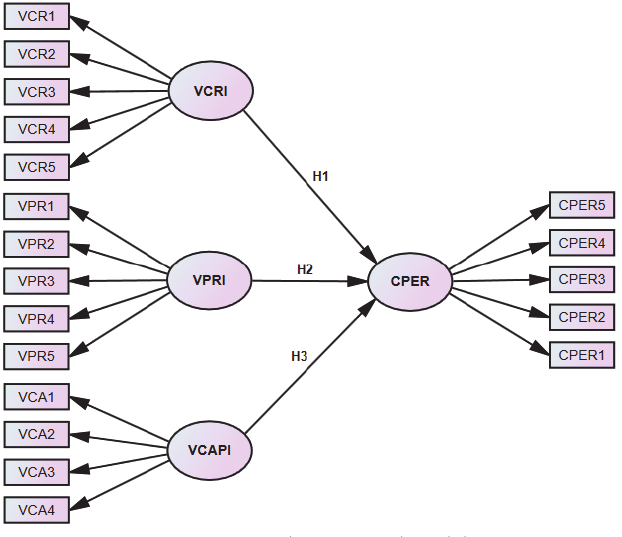
Fig. 1. Research conceptual